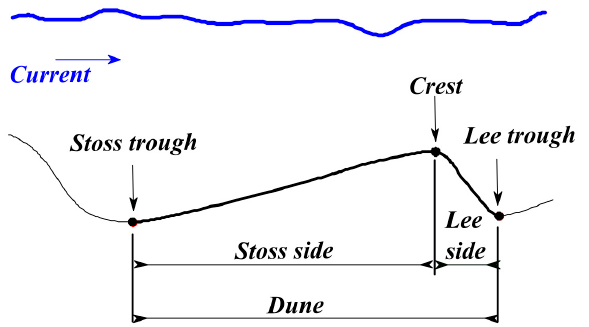
Figure 1. Representation of a dune profile with the crest line, the lee and stoss troughs, and the lee and stoss sides.